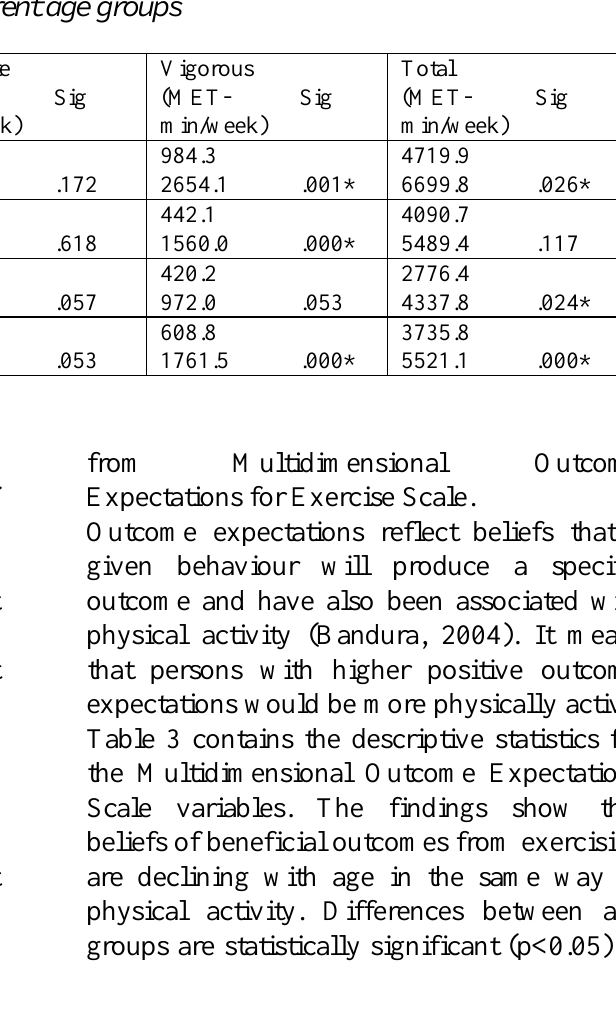
Table 2. Mean values for physical activity in metabolic equivalents-minutes per week (MET- min/week) in male (M) and female (F) of different age groups